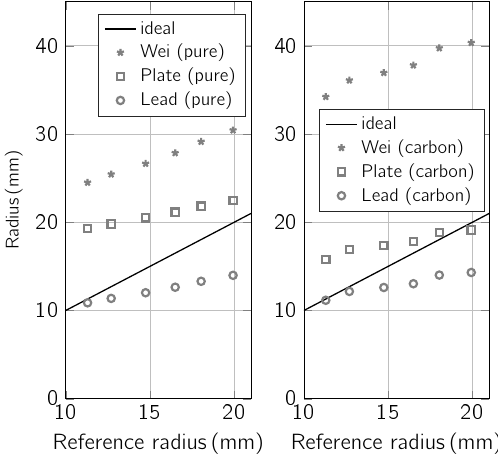
Figure 7: Estimated radii by the ACMs (Wei, Plate, Lead) obtained from the conductances measured inside the in-vitro phantoms compared to reference radii (Data). Left: insulating phantom of pure silicone, right: silicone phantom enriched with